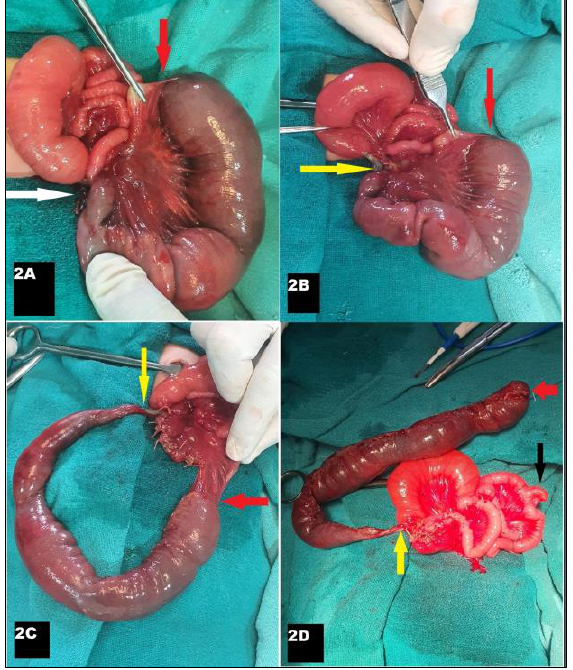
Figure 2: Intraoperative findings. A: type 1 Jejunal atresia Figure 1: Features at the time of admission. A- Upper (red arrow) and knotting of proximal dilated jejunum by abdominal fullness (blue arrow). B. X-ray abdomen erect- distal unused ileum (white arrow). B &C: Second atresia dilated stomach (yellow arrow) and 4-5 air-fluid levels at over proximal dilated jejunum at the site of knotting (yellow the center of the upper abdomen (red arrow) with rest of arrow). D: Meckel’s diverticulum (black abdomen gasless.